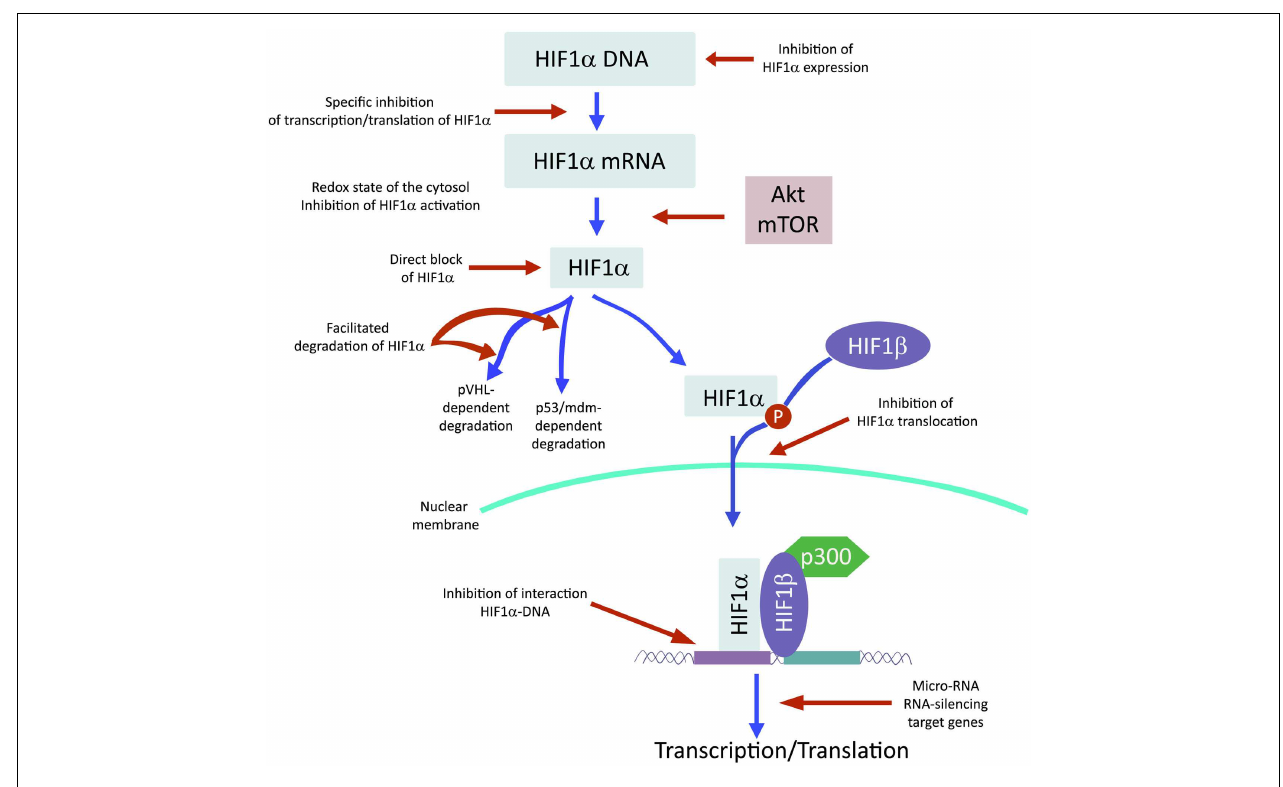
FIGURE 2 | HIF1 α activation can be inhibited at different steps along the